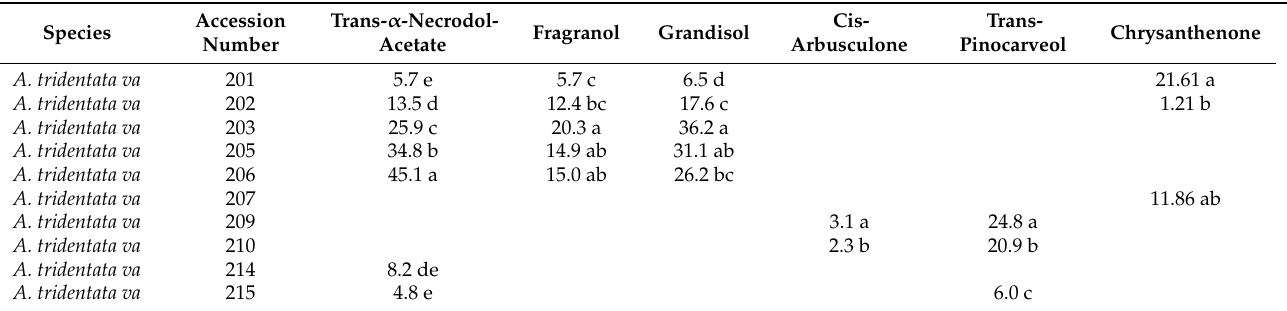
Table 4. Mean trans- α -necrodol-acetate, fragranol, grandisol, cis-arbusculone, trans-pinocarveol and chrysanthenone (all in %) from 10 collections of the A. tridentata Nutt. var. vaseyana (Rydb.) Boivin. Blank cells indicate the constituents were not obtained from these accessions. A. tridentata va = A. tridentata Nutt. var. vaseyana